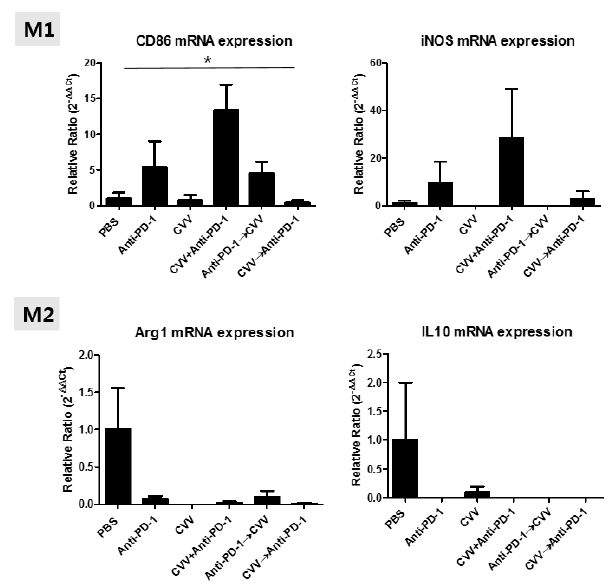
Figure 7. mRNA expression patterns of M1 (CD86 and iNOS) and M2 (Arg1 and IL10) markers from CT26 tumors. After 40 days, tumors derived from responders were harvested, total RNA was extracted, and cDNA was synthesized for mRNA quantification.* p < 0.05, one-way ANOVA. Vaccines 2020 , 8 , x FOR PEER REVIEW